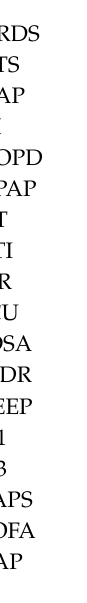
Table S1. Significant univariate and multivariate Cox regression analyses of variables associated with 28-day mortality, Table S2. Significant univariate and multivariate Cox regression analyses of variables associated with 90-day mortality, Table S3. Clinical outcomes of 72 patients with VAP who did and did not develop ARDS during 2004–2007, Table S4. Clinical outcomes of 113 patients with VAP who did and did not develop ARDS during 2008–2010, Table S5. Clinical outcomes of 81 patients with VAP who did and did not develop ARDS during 2011–2013, Table S6. Clinical outcomes of 35 patients with VAP who did and did not develop ARDS during